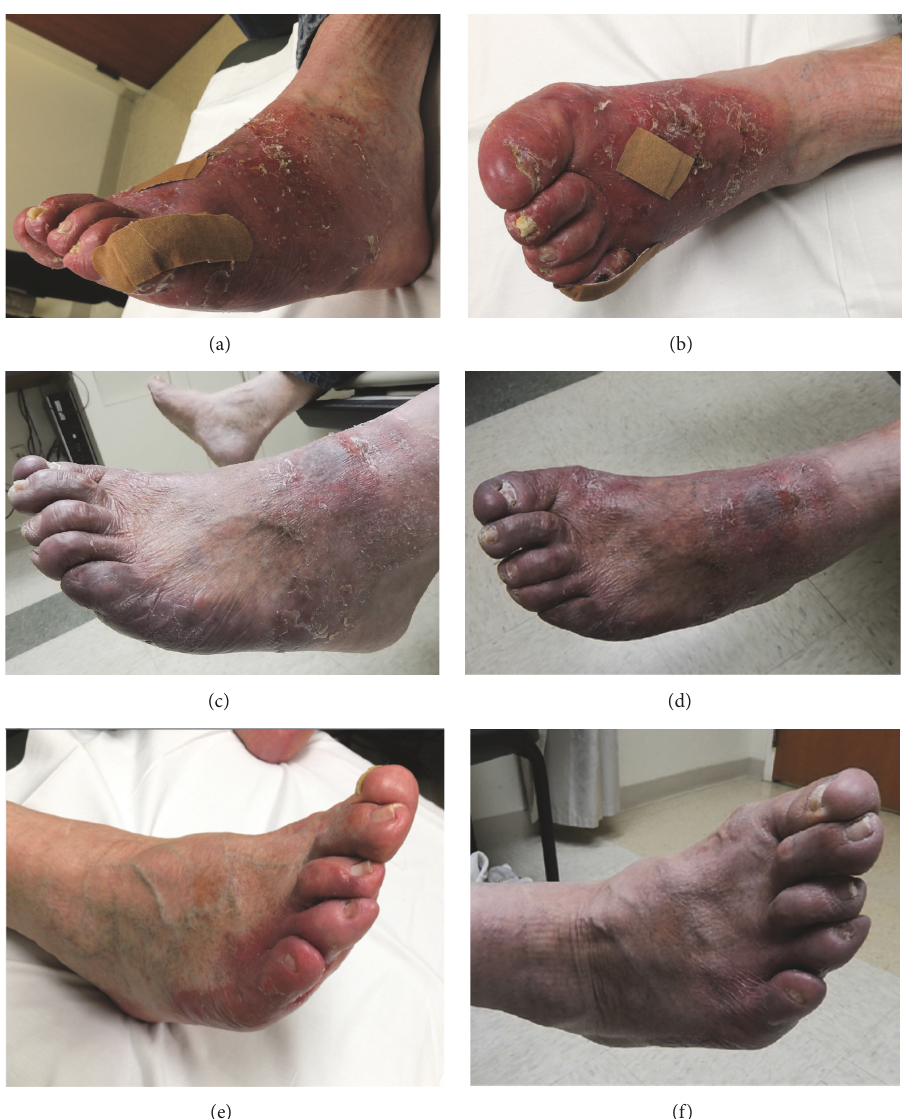
Figure1:(a)and(b)Leftfootatpresentation.(c)and(d)Leftfootatfollow-up11months laterwithanew3-4 cmcircularlesionthatdeveloped just proximal to the irradiated area. (e) Right foot at presentation. (f) Right foot at follow-up 11 months